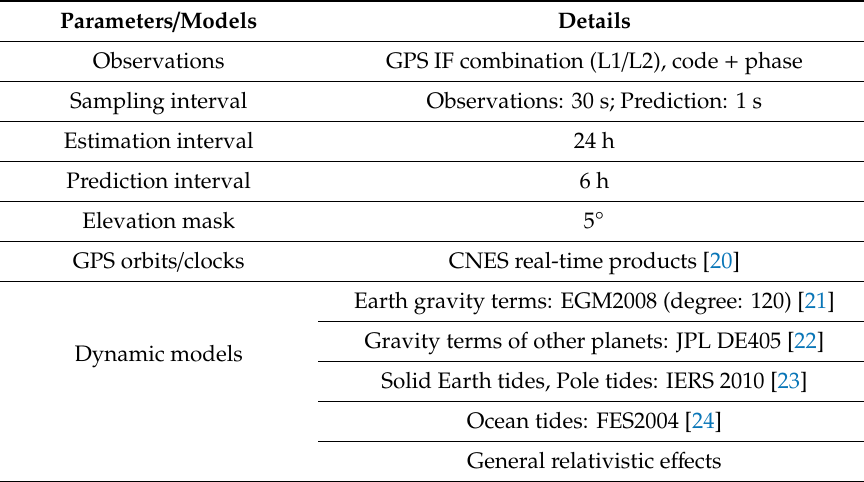
Table 3. Processing parameters and the dynamic models used in the processing. The following abbreviations are used: CNES for the National Centre for Space Studies in France, JPL for the Jet Propulsion Laboratory in the USA, and IERS for the International Earth Rotation and Reference Systems